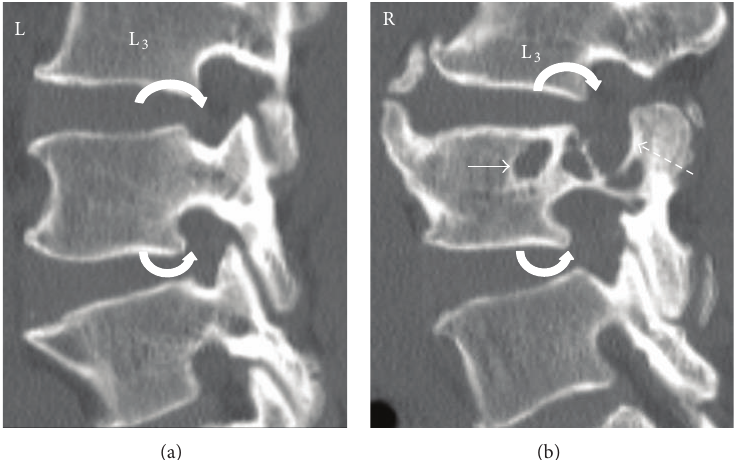
Figure 3: Coned-in sagittal-oblique reformatted CT images of L3 to L5 (bone window) showing the normal left and affected right side with pressure erosion of the L4 vertebral body (white straight arrow) and its posterior elements (dashed arrow). Moderate widening of the right L3/4 and L4/5 exit foramina (curved arrows) is present compared to the normal left